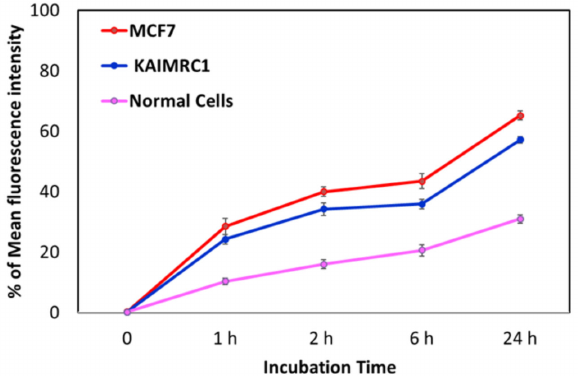
Figure 6. Flow cytometry analysis of FITC-labeled IO-MMNs. Uptake of IO-MMNs by two different cancer cell lines and normal primary cells as measured by fluorescence-activated cell sorting (FACS) after incubating the labeled particles with the cells at different time points. The cellular uptake was slightly higher for MCF-7 compared to KAIMRC-1, with least uptake for normal primary cells. Data are presented as mean values ± standard deviations.